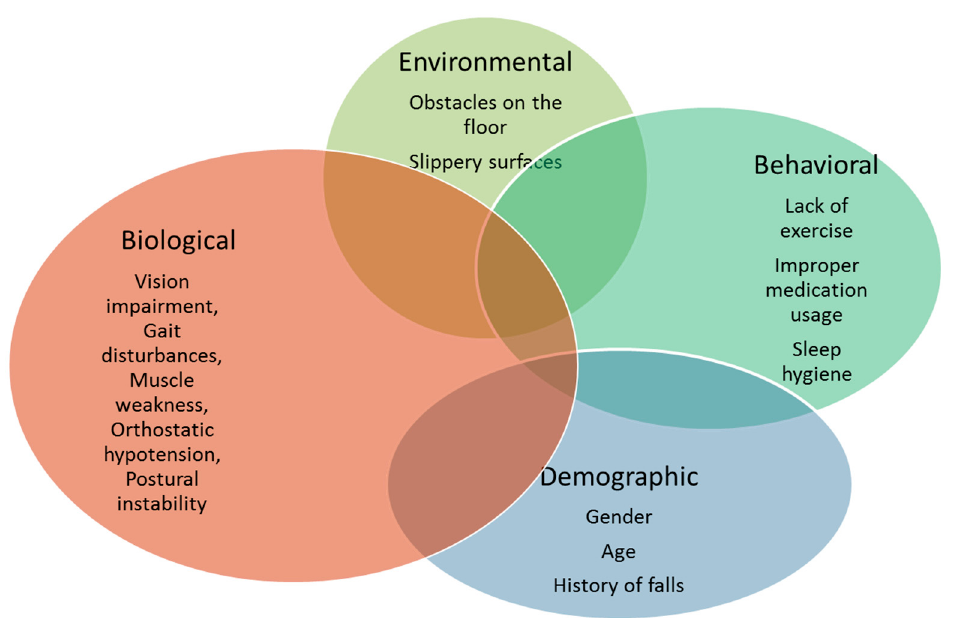
Figure 1. Interaction between various fall risk factors.